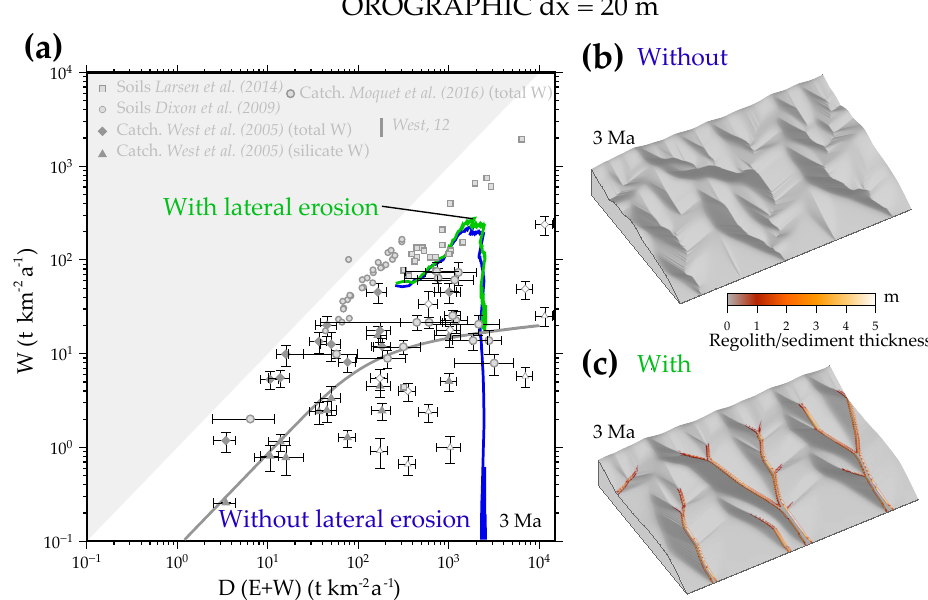
Figure 12. OROGRAPHIC experiments using a smaller cell size of 20m (mountain size / 25) (Table 1). The mountain erosion increases faster than in other experiments. Thus the cooling and drying steps are applied at 0.5, 1, 1.5, and 2Ma. The final maximum elevation at 3Ma is 1200m. The precipitation rate is thus maximum at mountaintop (orographic model 1 illustrated in Fig. 8). (a) Weathering rate for the experiment with and without lateral erosion. (b) Topography and regolith or sediment thickness at 3Ma in the case without lateral erosion. (c) The same for the case with lateral erosion, showing the colluvium in valleys. Relief ×